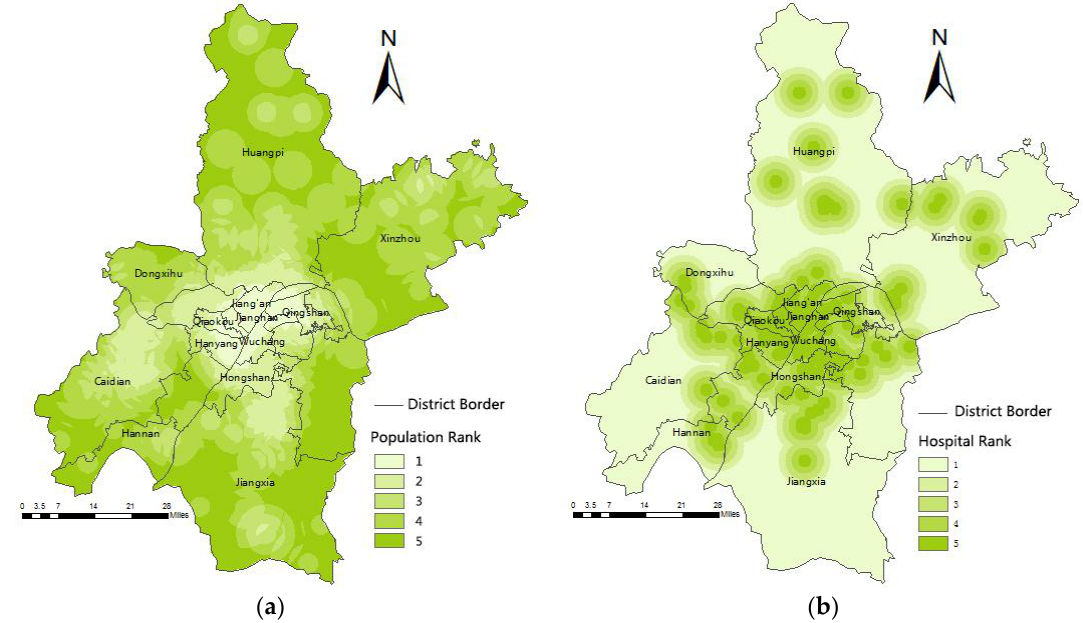
Figure 5. Suitable map after reclassification. ( a ) These regions refer to the population points. The lower the value is, thegreater the population intensity is. ( b ) These regions are about existing hospitals. The lower the value is, the more a new hospital is necessary.